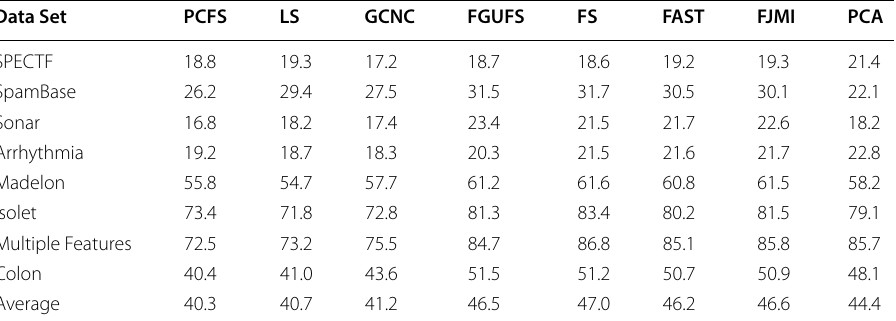
Multiple Features Colon